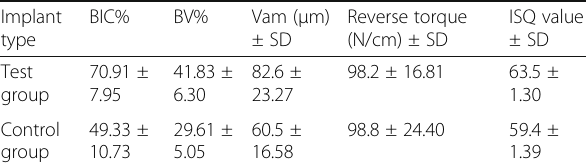
Table 2 Mean values of histomorphometric parameters (%BIC and %BV) and biomechanical values (VAM, reverse torque, and ISQ) of each implant group